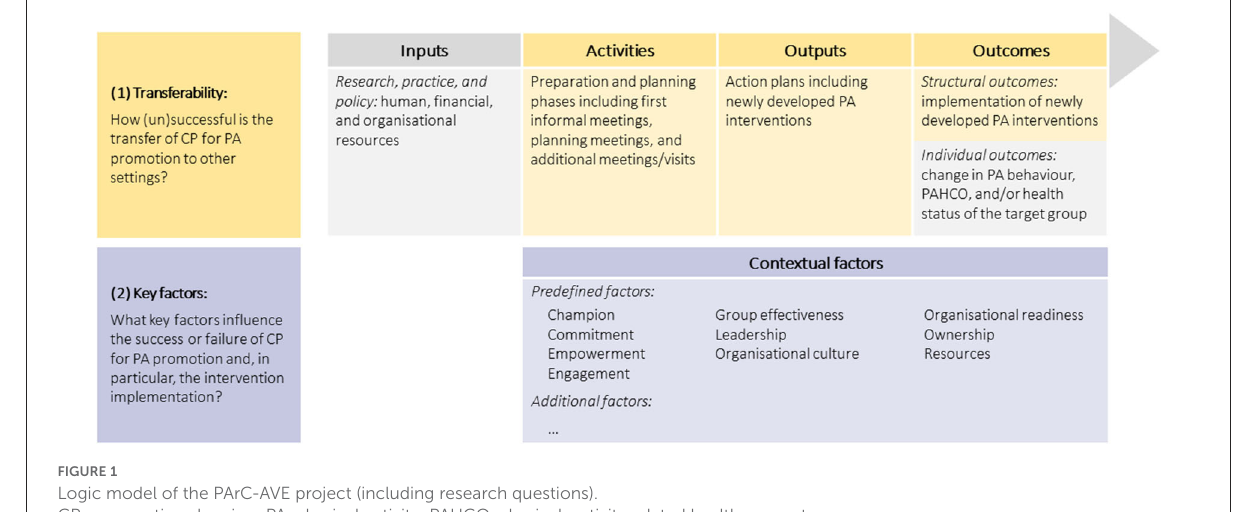
FIGURE1 Logic model of the PArC-AVE project (including research questions). CP, cooperative planning; PA, physical activity; PAHCO, physical-activity related health